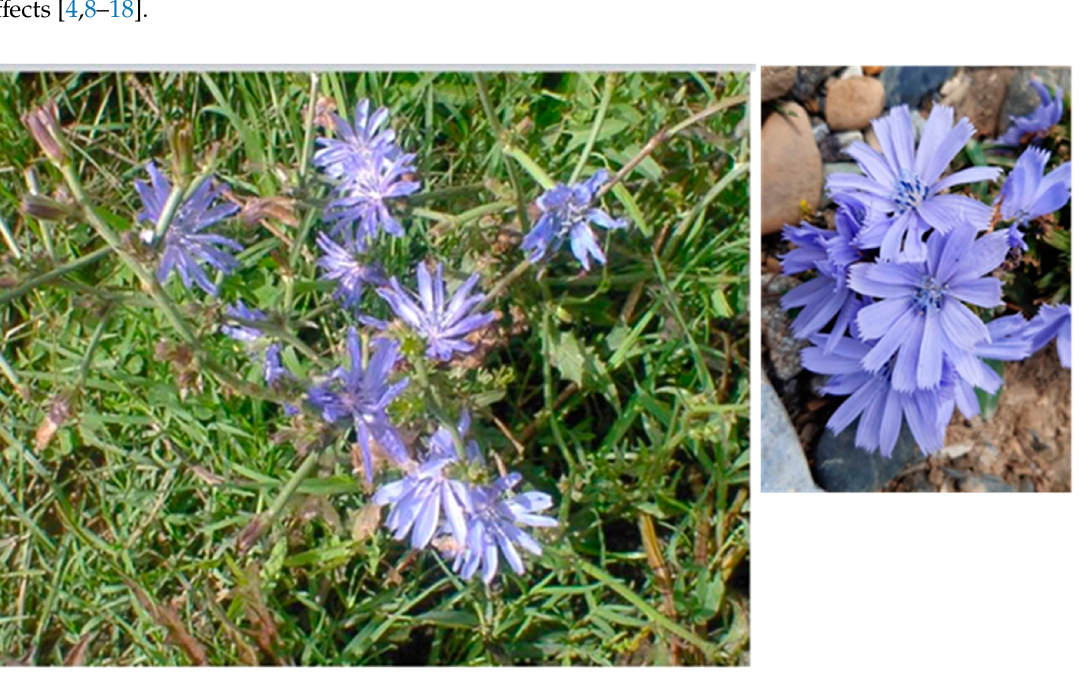
Figure 1. C. intybus photographed by the authors.